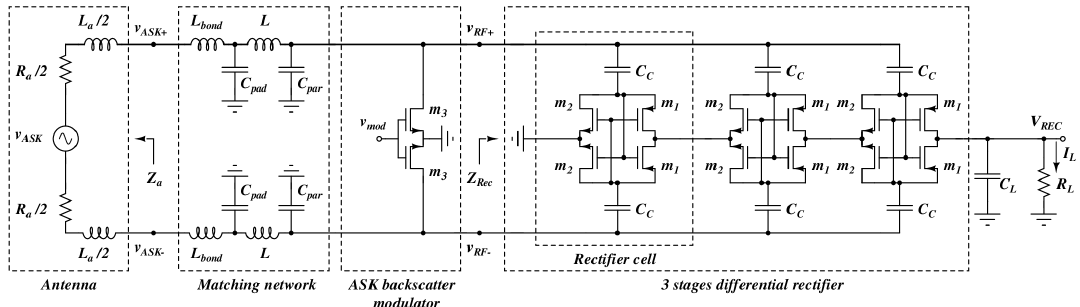
Figure 9. Schematic circuit of the HF